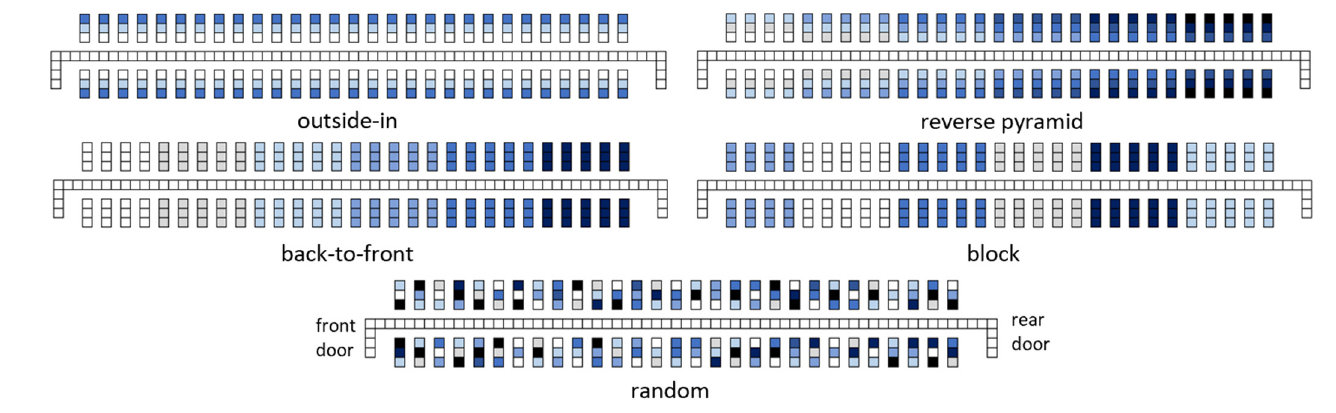
Figure 4. Grid model to represent different boarding strategies. Source: derived, adapted, modified, assembled and commented from Schultz 2017, p. 134 [53].